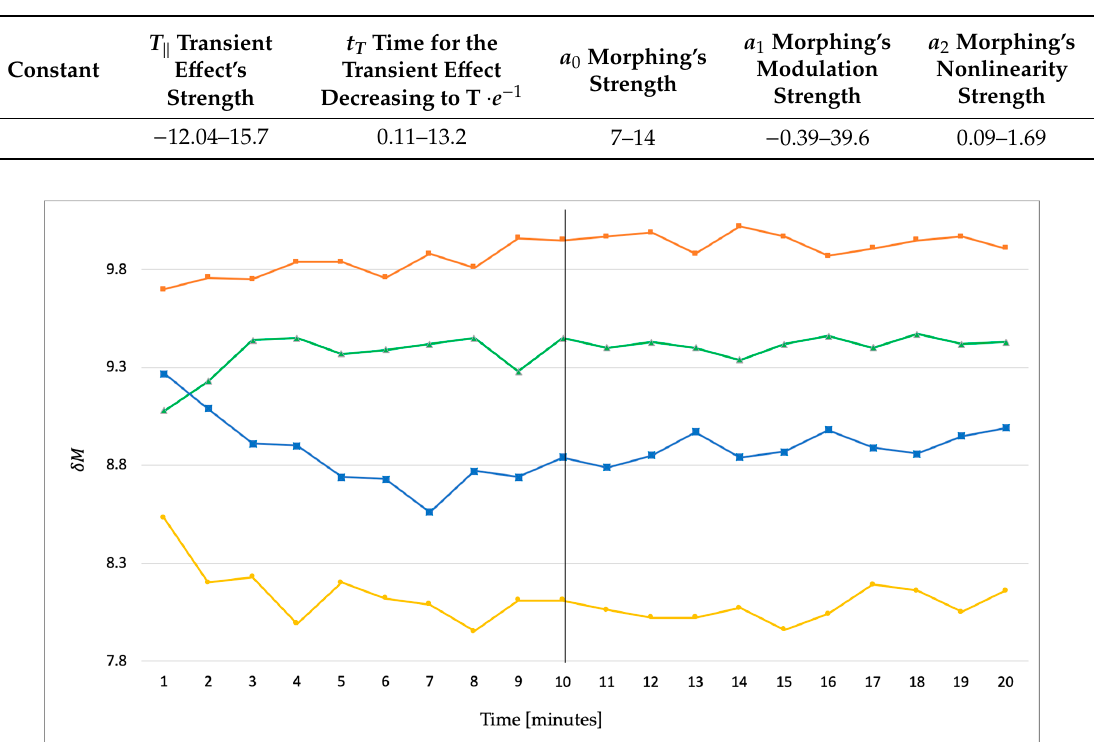
Figure 6. Four examples (subject 10 = orange, 9 = green, 2 = blue, 5 = yellow) showing different progressions of transient oscillations which have subsided after minute 10.